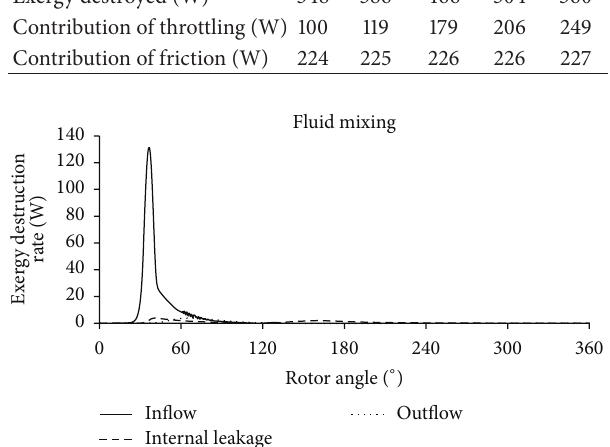
Figure 6: Exergy destruction rate due to fluid